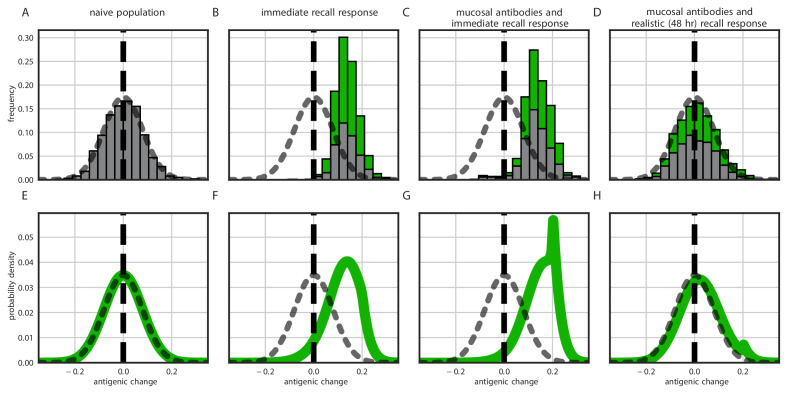
Distribution of mutant effects given replication and inoculation selection, with a transmission threshold model.Threshold version of Figure 4. Distribution of antigenic changes along 1000 simulated transmission chains (A–D) and from an analytical model (E–H). In (A,E) all naive hosts, in other panels a mix of naive hosts and experienced hosts. Antigenic phenotypes are numbers in a 1-dimensional antigenic space and govern both sIgA cross immunity, σ, and replication cross immunity, c. A distance of ≥1 corresponds to no cross immunity between phenotypes and a distance of 0 to complete cross immunity. Gray line gives the shape of Gaussian within-host mutation kernel. Histograms show frequency distribution of observed antigenic change events and indicate whether the change took place in a naive (gray) or experienced (green) host. In (B–D) distribution of host immune histories is 20% of individuals previously exposed to phenotype −0.8, 20% to phenotype −0.5, 20% to phenotype 0 and the remaining 40% of hosts naive. In (E), naive hosts inoculate naive hosts. In (F–H) hosts with history −0.8 inoculate hosts with history −0.8. Initial variant has phenotype 0 in all sub-panels. Model parameters as in Table 1, except k=25. Spikes in densities occur at 0.2 as this is the point of full escape in a host previously exposed to phenotype −0.8.